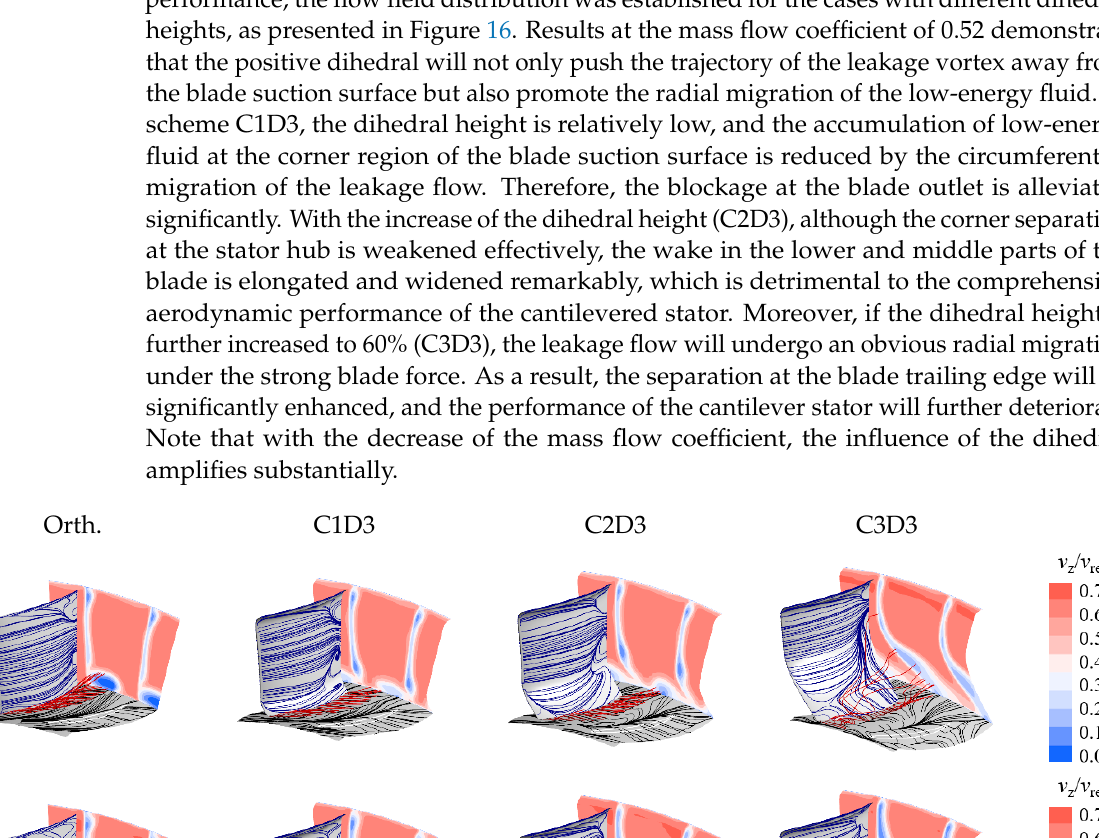
( b ) Figure 17. Radial distribution of aerodynamic performances for the cases with different dihedral heights. ( a ) φ = 0.52; ( b ) φ = 0.46. Figure 18 presents the variation of the leakage mass flow rate. An interesting phe- nomenon is that increasing the dihedral height will first increase and then decrease the leakage mass flow rate at the blade leading edge. Consequently, the uniformity of the leakage flow characteristic along the blade chord is first decreased and then increased. Moreover, although the slight positive dihedral (C1D3) could increase the mass flow rate of the leakage flow along the axial direction, increasing the dihedral height will incur a significant reduction of leakage flow at the blade leading edge, thus weakening the effect of the 3D blading technique. 0.2